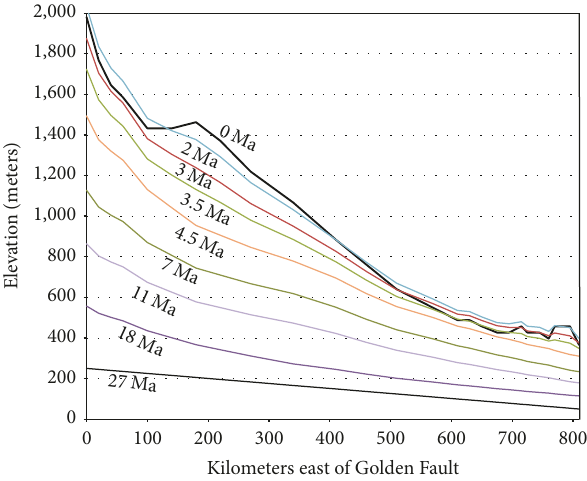
Figure 17: Stacked land surfaces of the 9 MODFLOW models showing progressive uplift from 27 Ma to 0